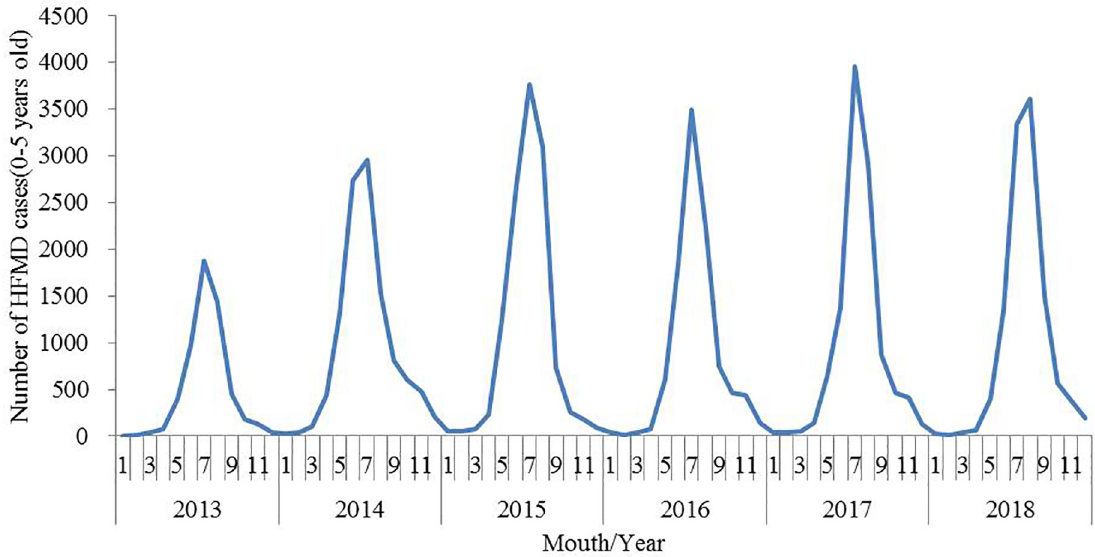
Fig 1. Monthly number of HFMD cases in Qingdao City,